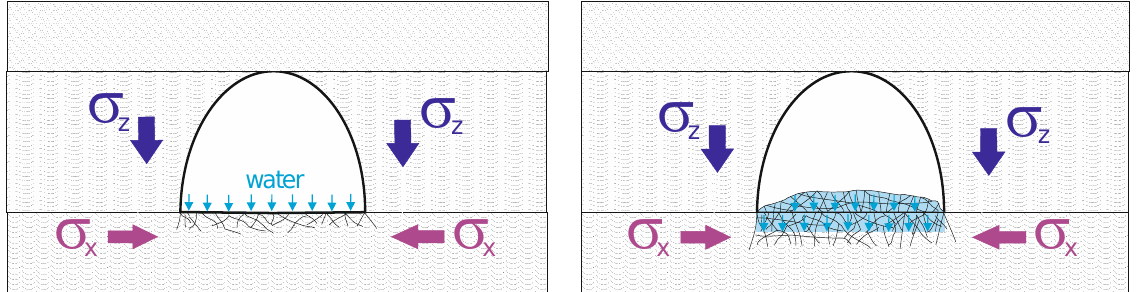
Figure 4. Gradual permeation of water through fractured zone into the rock mass on the floor.